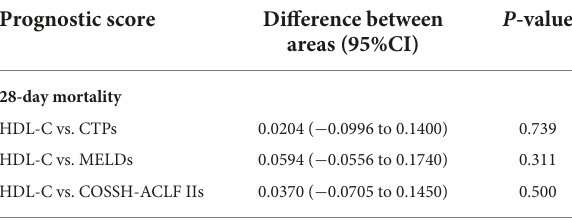
TABLE 5 The comparison of predictive value between high-density lipoprotein cholesterol (HDL-C) and scores. Prognostic score